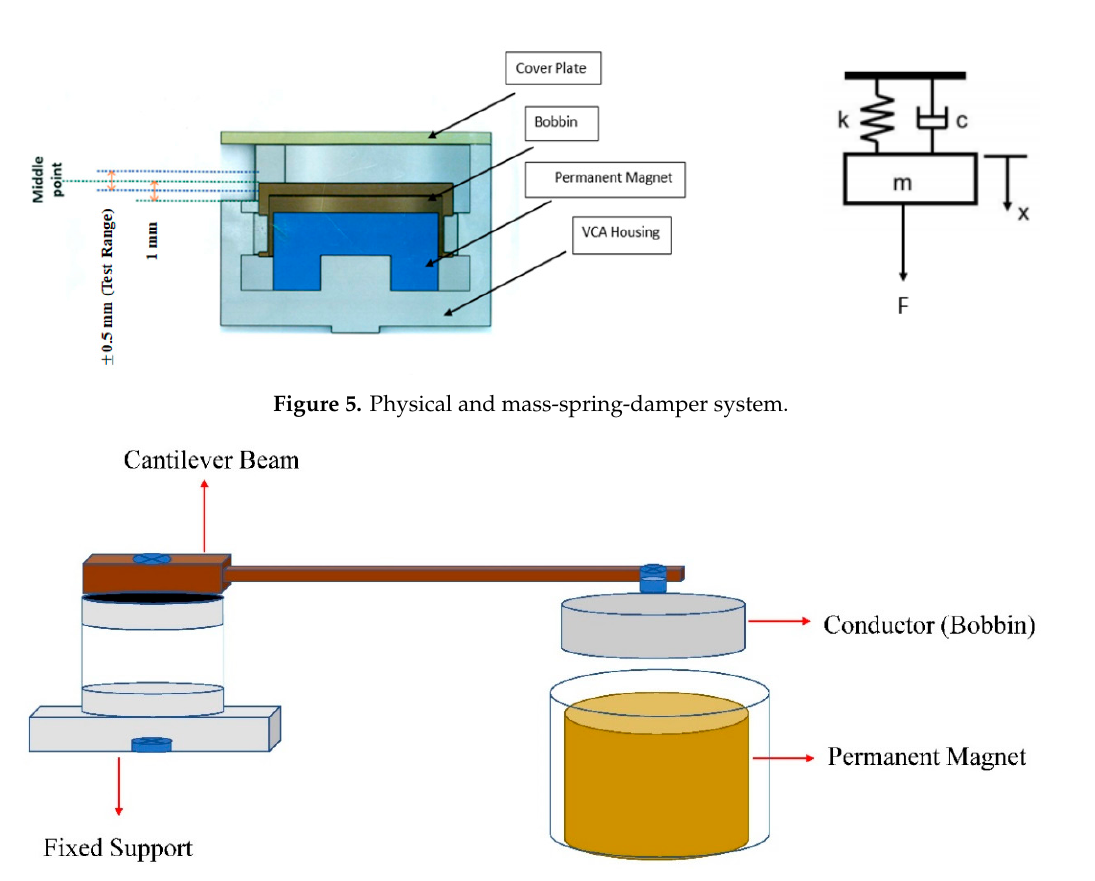
Figure 6. Cantilever beam in magnetic field generated by permanent magnet.